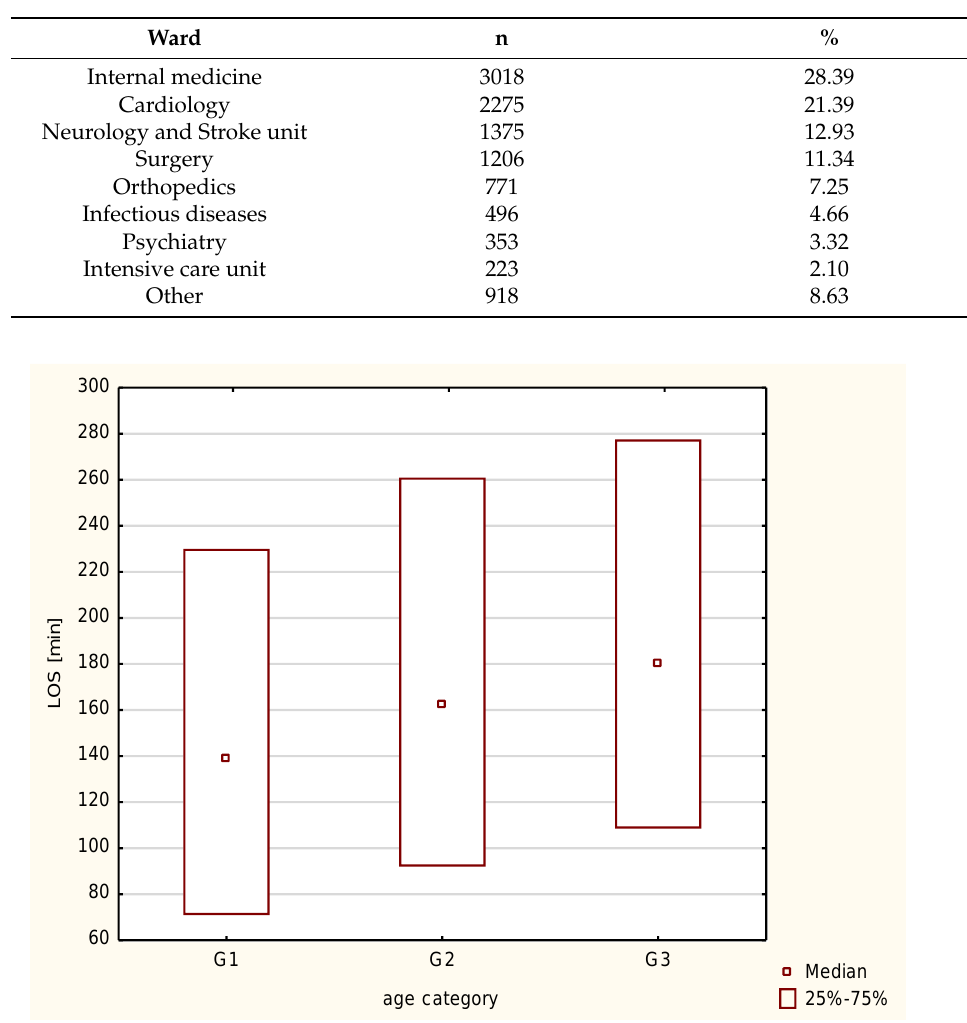
Figure 1. Graphical presentation of the length of stay in the emergency department in particular subgroups. G1—elderly age; G2—senile age; G3—long-livers; LOS—length of stay in the emergency department.